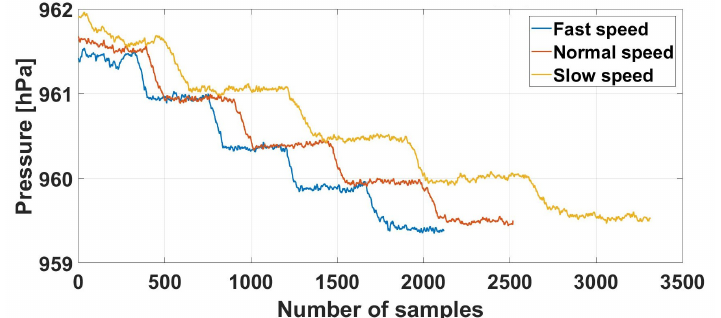
Figure 13. Dataset used for the evaluation of the stair removal method. The data was collected from the same route for three different visits and walking velocities, approximately 1 × , 1.5 × and 2 × [15].